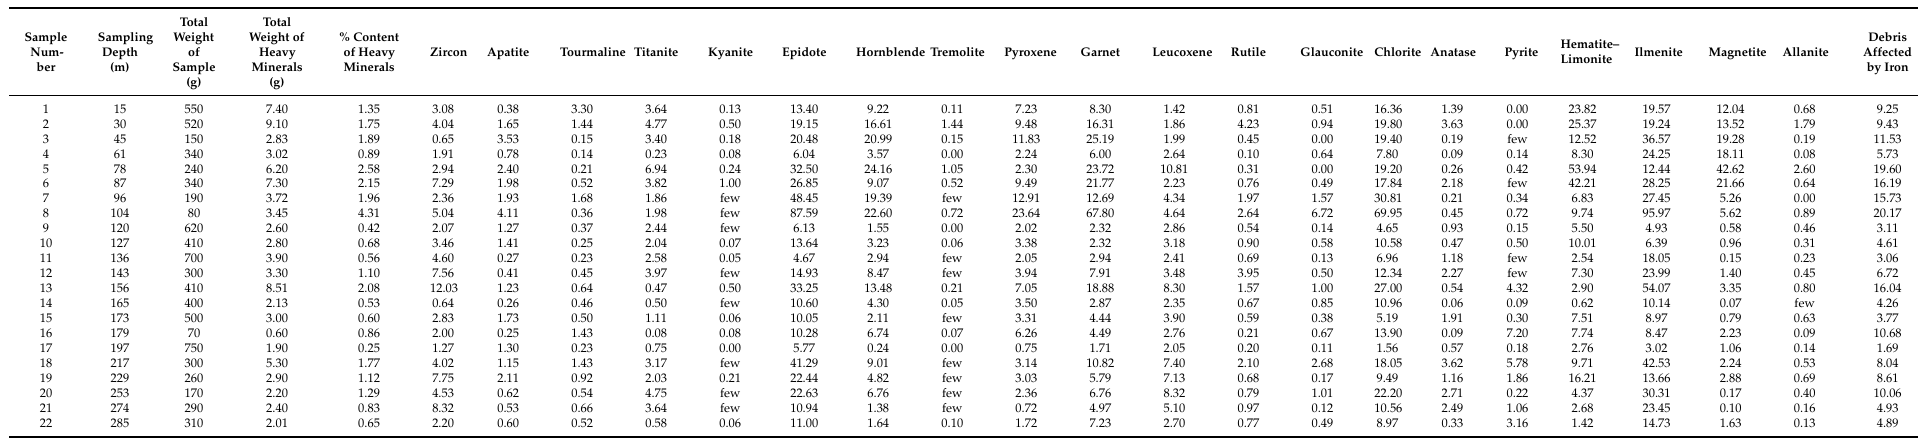
Table 1. Heavy mineral contents of the Zhoulao